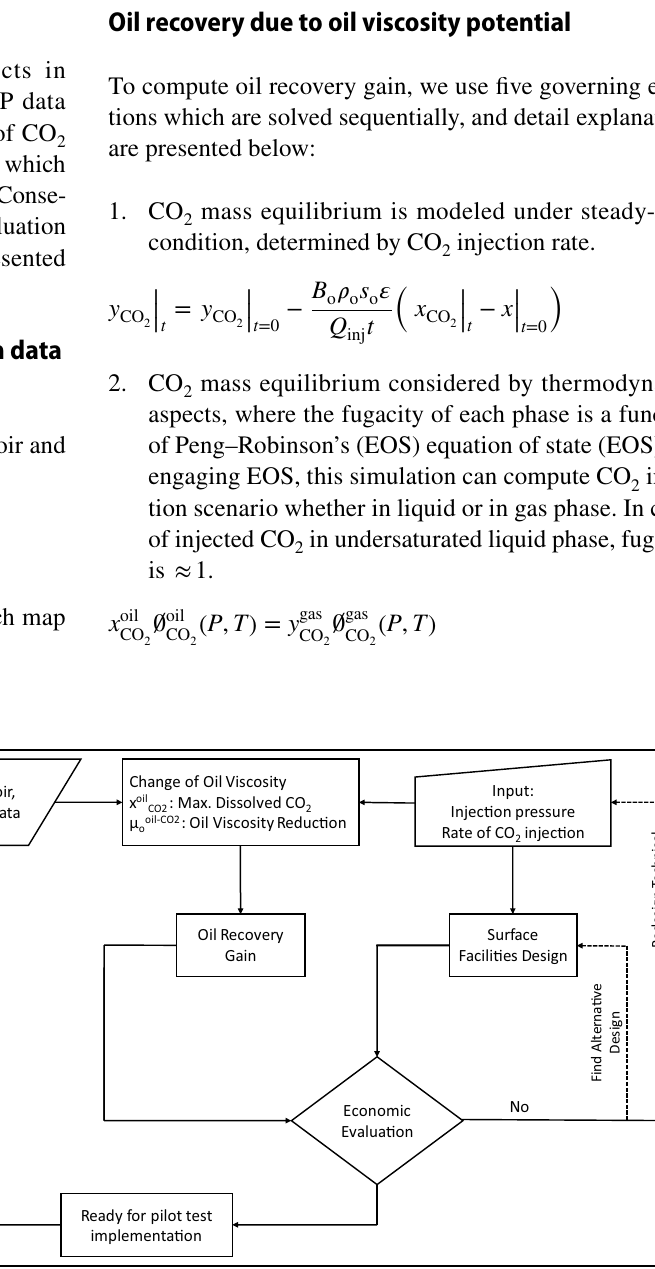
Change of Oil Viscosity x oil CO2 : Max. Dissolved CO 2 μ o oil-CO2 : Oil Viscosity